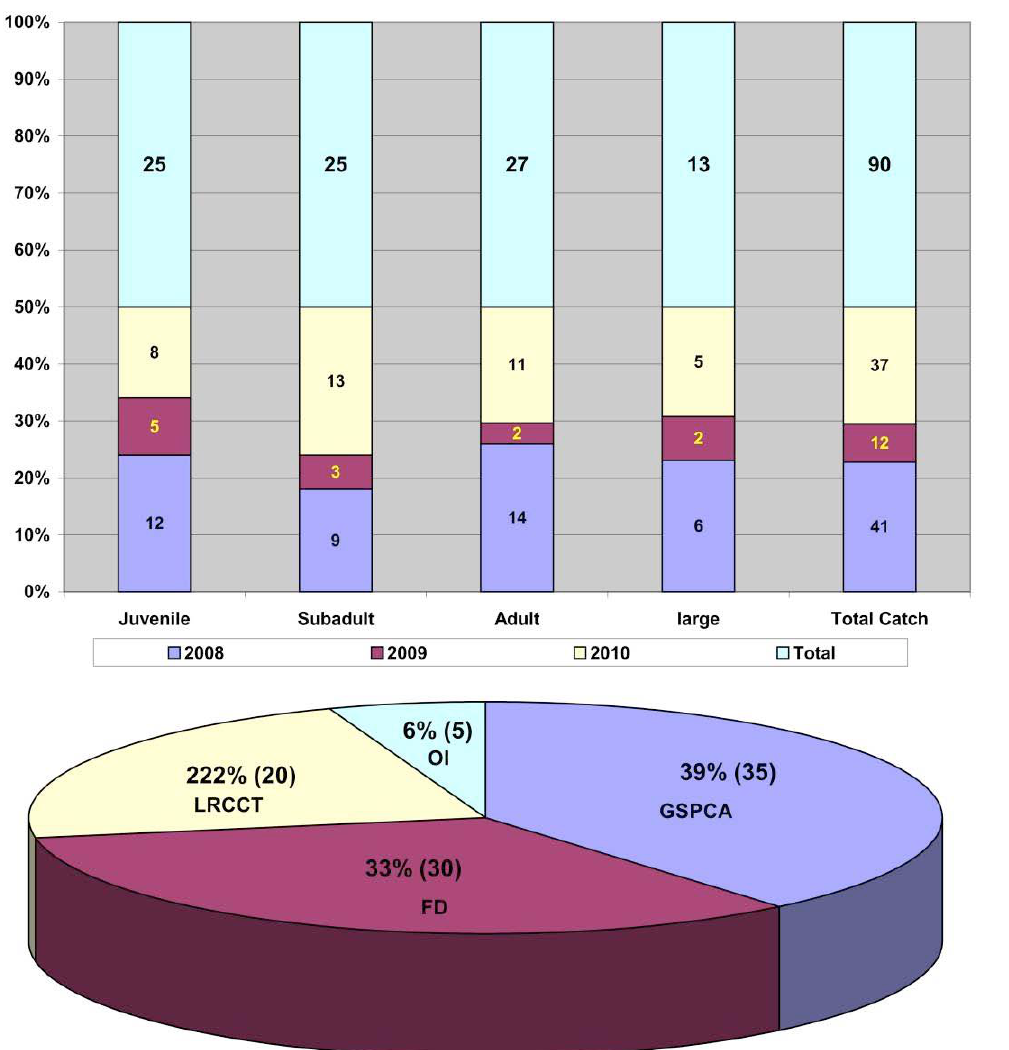
Figure 1. Size class of Muggers rescued from Vadodara City during 2008–2010 by Forest Department (FD)) and Non Governmental Organizations. GSPCA - Gujarat Society for the Prevention of Cruelty to the Animals; LRCCT - Let. Rohan Crocodile Charitable Trust; OI - Others Individuals).